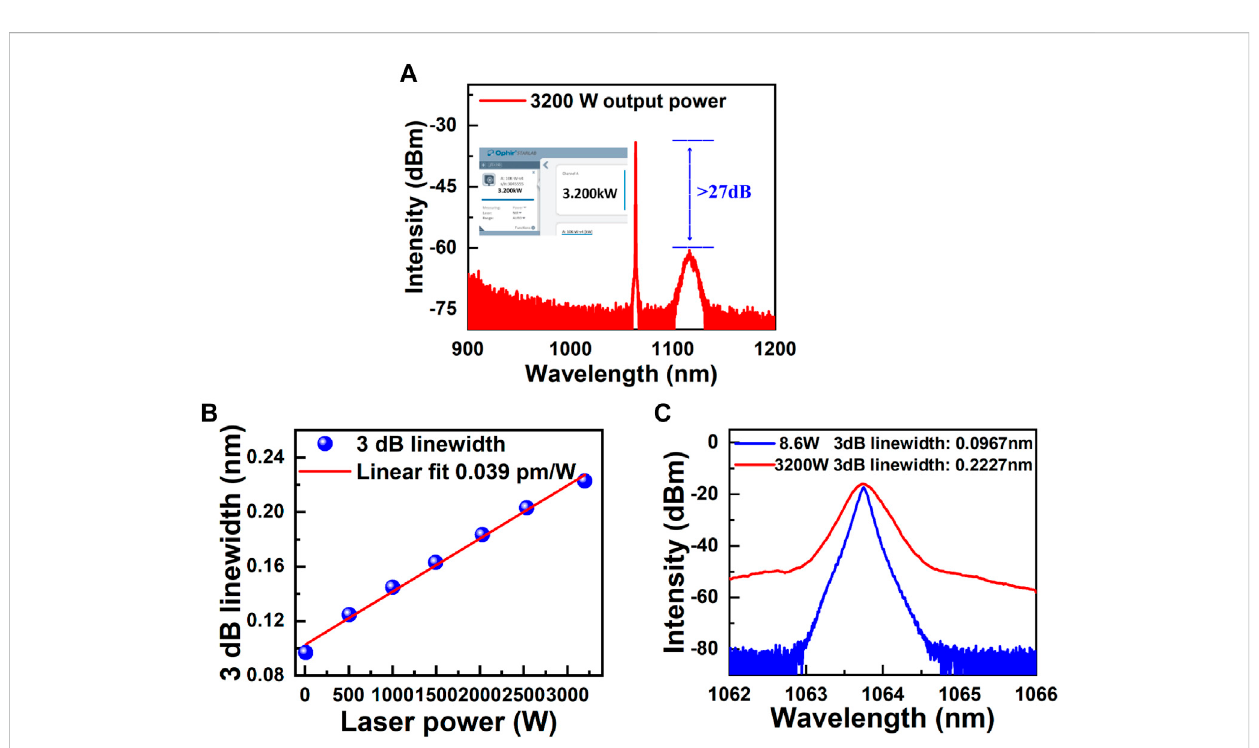
FIGURE 7 (A) Spectrum of the MOPA system at the laser power of 3.2 kW. (B) 3 dB linewidth versus the laser power. The 3 dB linewidths of 508 W, 1002 W, 1495 W,2027W,2538 W,and3.2 kWare0.1247nm,0.1447nm,0.1629nm,0.1833nm,0.2030nm,and0.2227nm,respectively. (C) SpectraoftheMOPA system at the laser power of 8.6 W and 3.2 kW, and the 3 dB linewidth are 0.0967 nm, and 0.2227 nm,